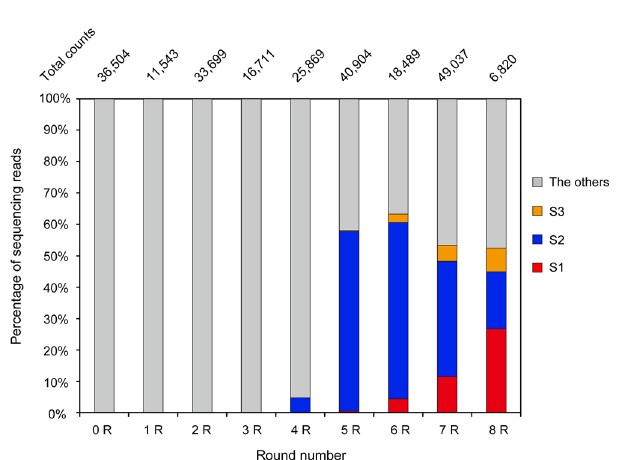
Figure 3. SPR analysis of the affinity of RNA pools from SELEX. SPR sensorgrams of interactions between RD and 0–8R RNA pools during SELEX. Sensorgrams of 0–8R pools are shown in black, gray, yellow, light green, green, cyan, blue, magenta, and red, respectively. Final concentration of RD was 10 nM.